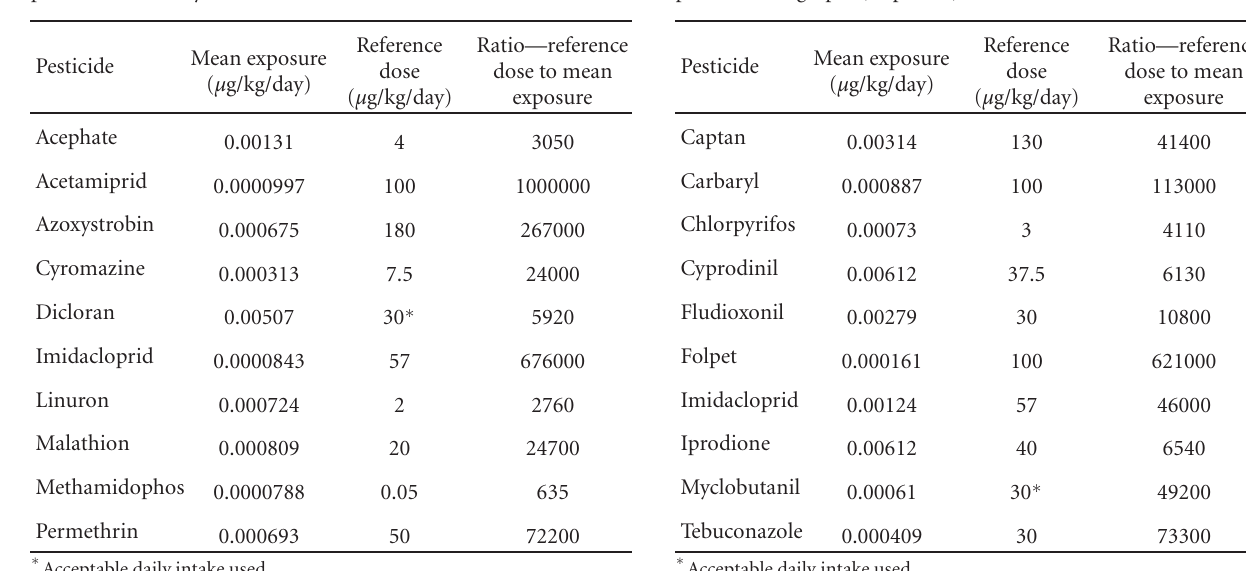
Table 5: Exposure estimates of the ten most frequently detected pesticides on celery.